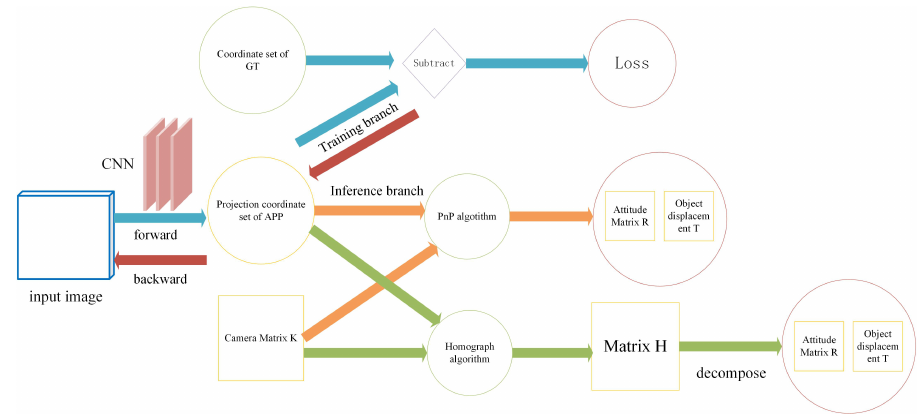
Figure 7. The schematic diagram of the 3D pose’s computational